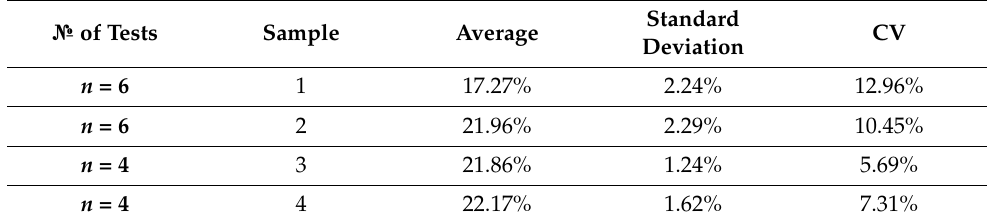
Table 4. Results for 0.75 g.